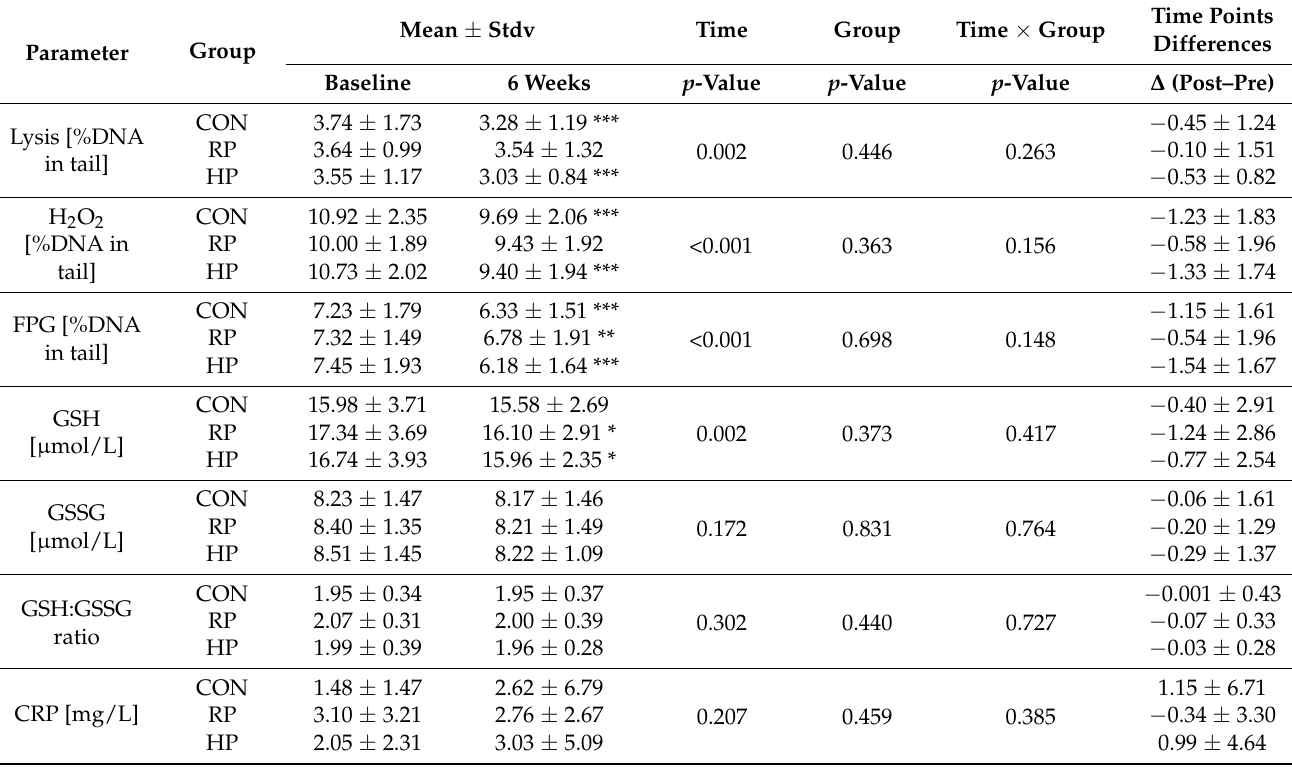
Table 6. Impact of the protein intervention on DNA damage marker in the Austrian study.